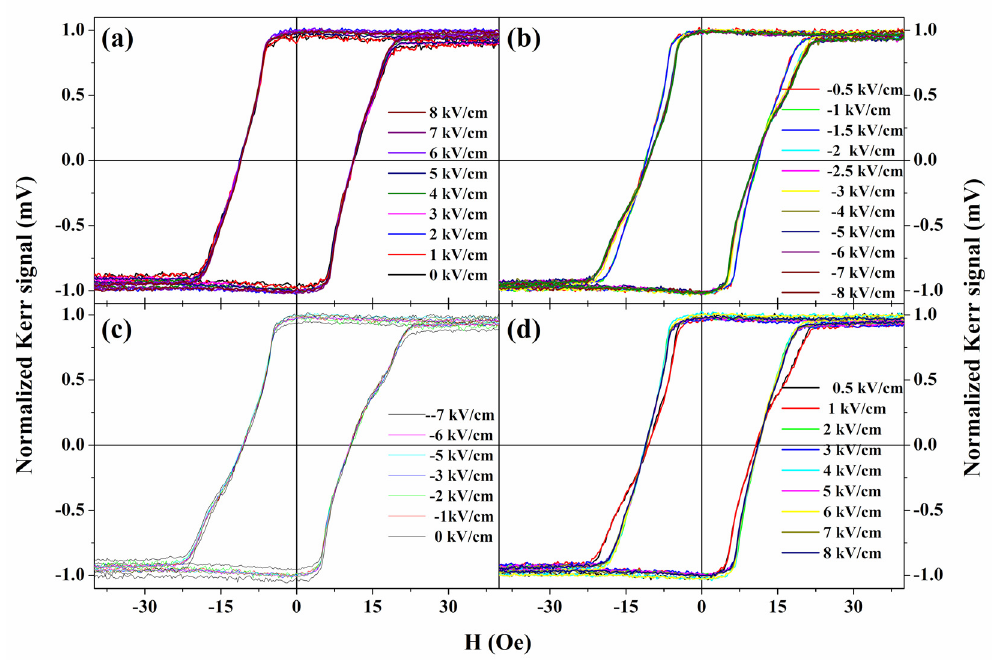
Figure 4. Longitudinal Kerr M–H loops as a function of bipolar electric fields (( a , c ) correspond to the descent branches of electric fields. ( b , d ) correspond to the ascent branches of electric fields) with H along the φ = 90° direction.